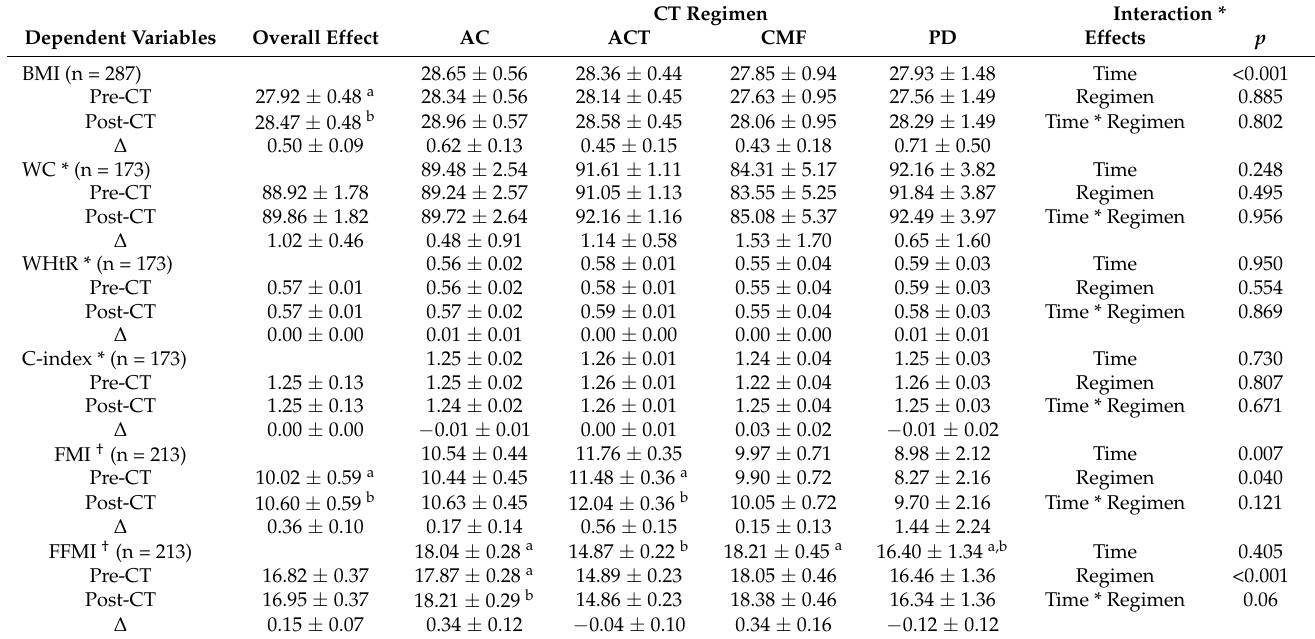
Table 4. Effect of the CT protocol and time on anthropometry and body composition, Brazil, 2004–2018. CT Regimen Interaction * Dependent Variables Overall